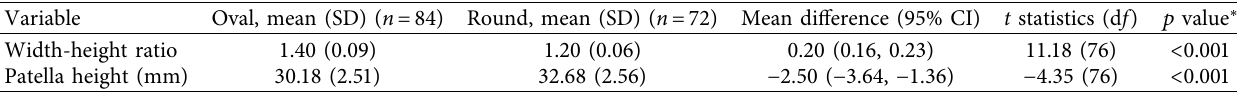
Table 4: Comparison of width-height ratio and patella height between the group of patients suitable for oval-shape implants and round- shape implants ( n �